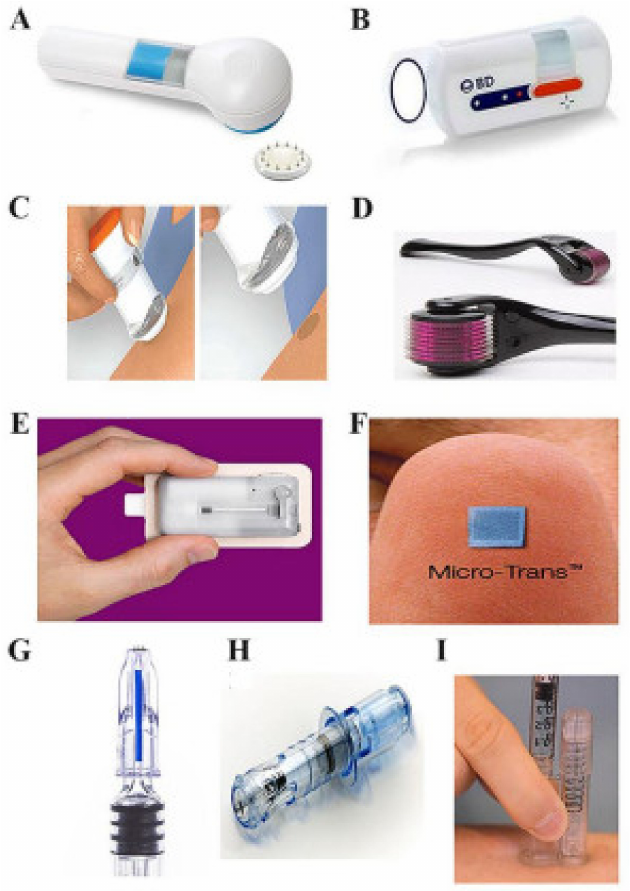
Figure 18. Commercially available MNs devices ( A ) Microstructured Transdermal Syst (B)